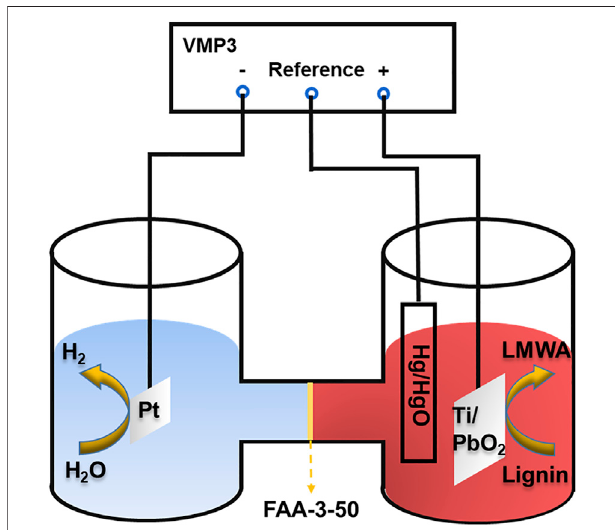
FIGURE 1 | H-type electrolysis cell used for